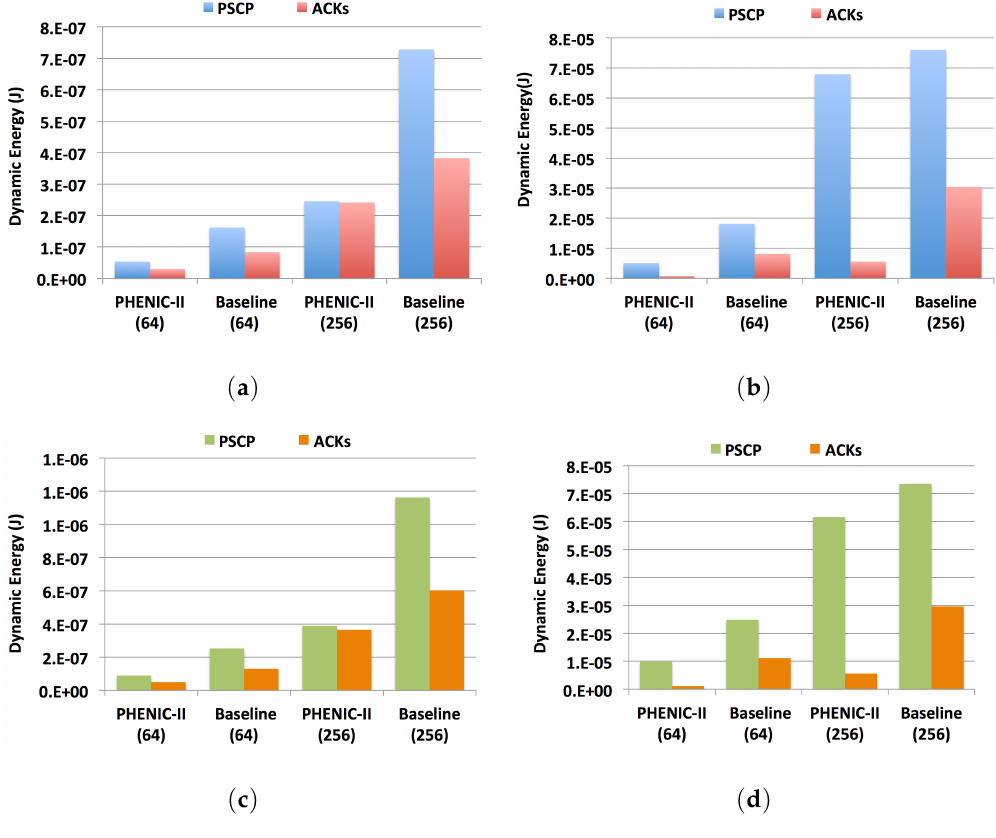
Figure 8. Path setup and acknowledgments energy: ( a ) half-load under random traffic; ( b ) near-saturation under random traffic; ( c ) half-load under bit reverse traffic; ( d ) near-saturation under bit reverse